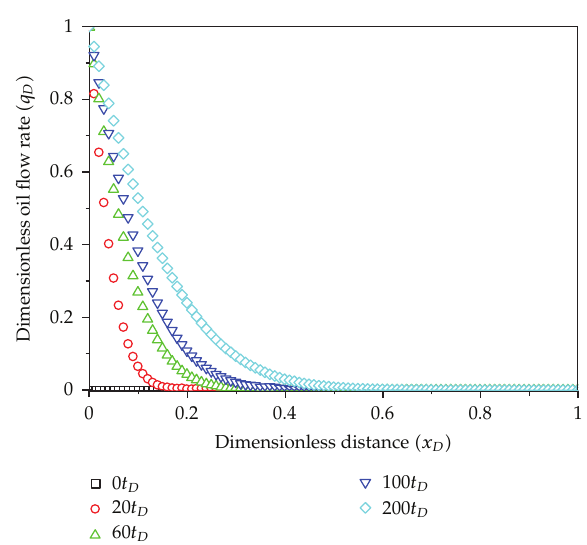
Figure 6: Results from dynamic simulation of the relationship of q D distribution in x D